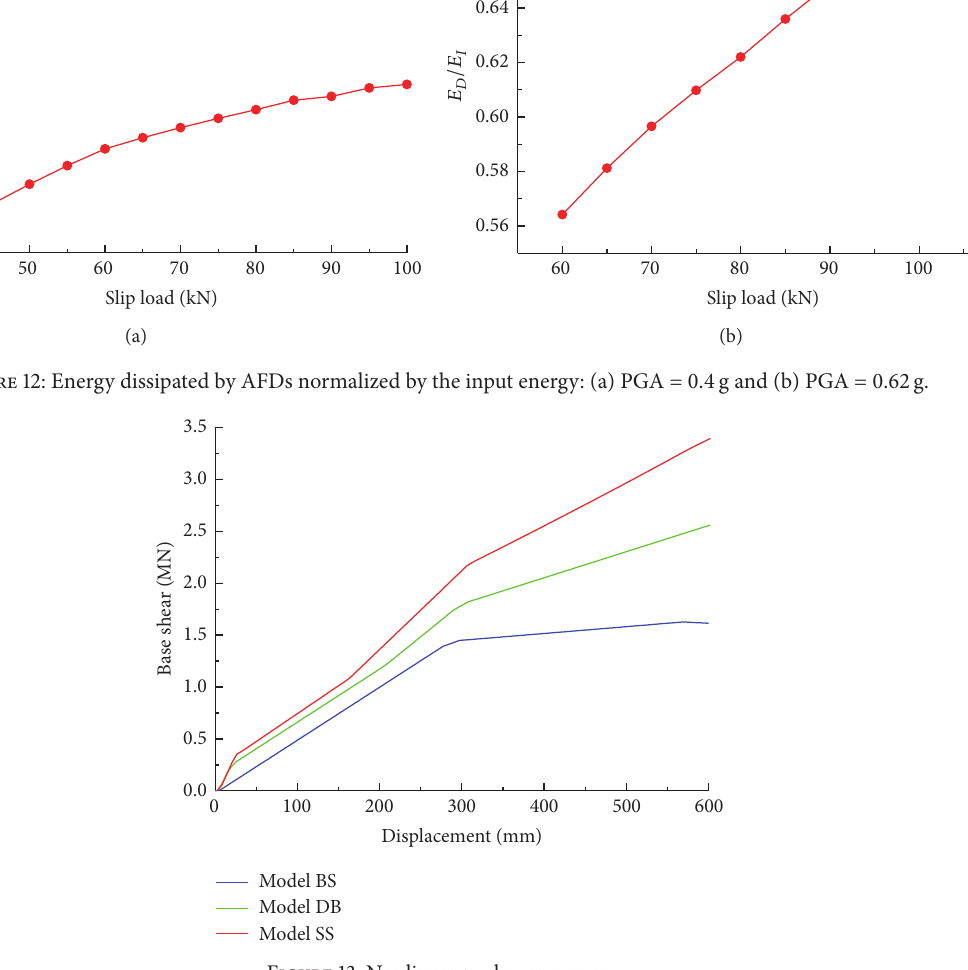
Figure 13: Nonlinear pushover curves.